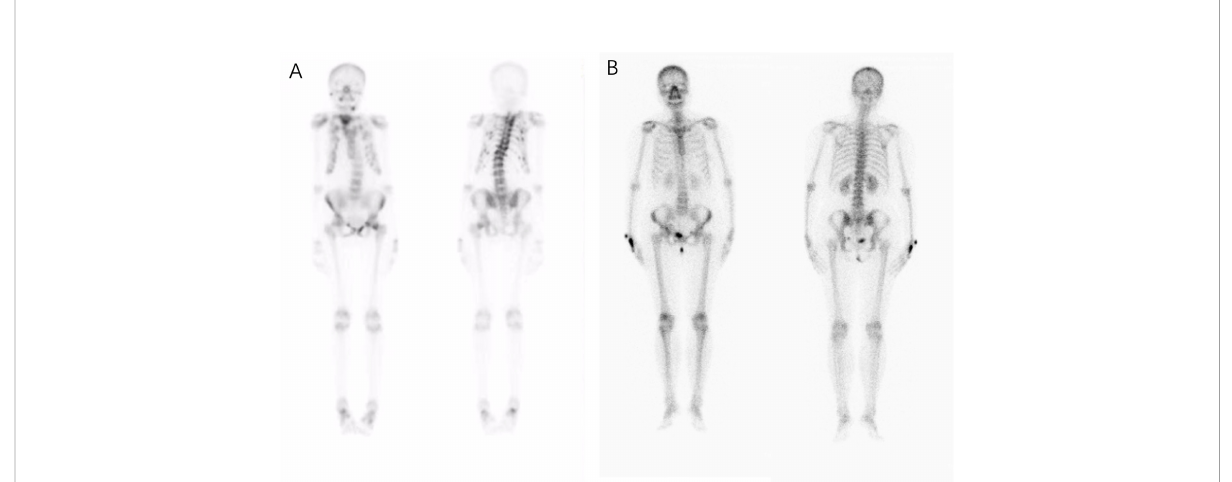
FIGURE 5 Whole body bone scan of the patients. Complete single-photon emission computed tomography whole-body bone scan at the onset of the disease detecting an increased uptake of radioactive tracers and possible osteomalacia changes in bone lesions. (A) In patients who were taking adefovir dipivoxil, scoliosis was obvious, multiple vertebral bodies became fl attened, multiple vertebral bodies and multiple ribs were abnormally distributed and concentrated, and local bone metabolism was active. (B) No obvious abnormal radioactive distribution or aggregation was found in the whole-body bone scan of the patient taking tacrolimus.